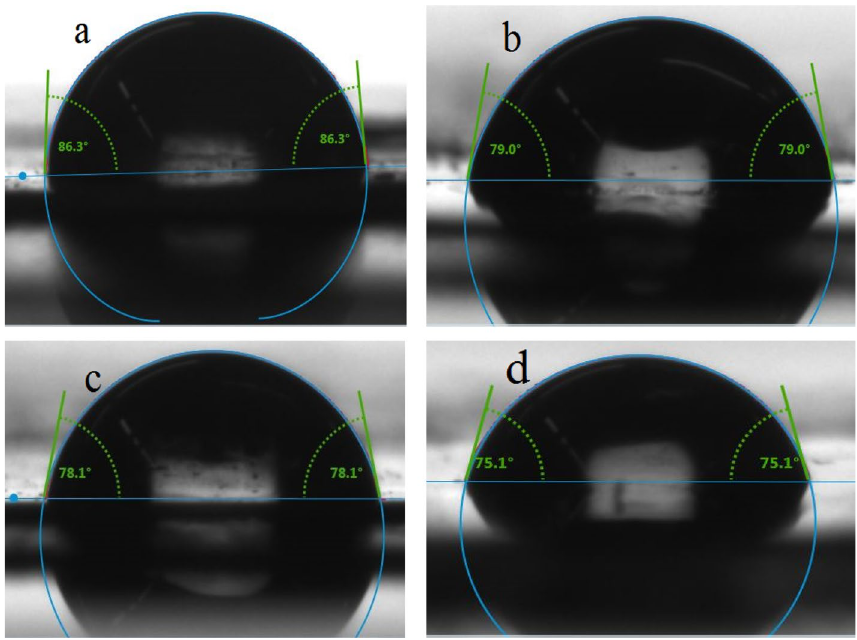
Figure 5. Contact angle of the fabricated PS/pTAP composite membranes, (a) PS/pTAP 100/0, (b) PS/pTAP 60/40, (c) PS/pTAP 50/50, (d) PS/pTAP